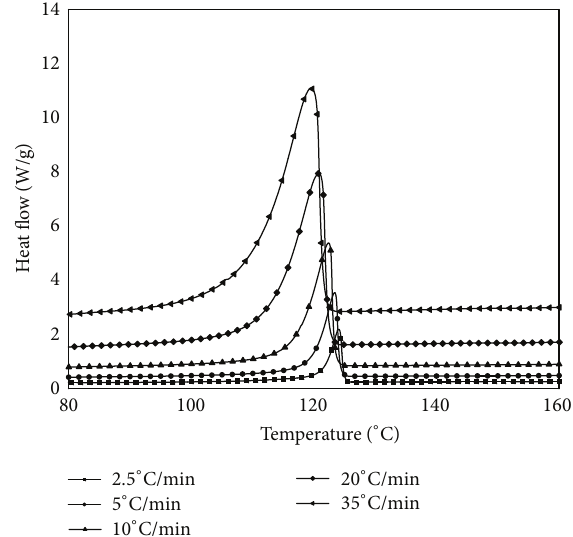
Figure 2: A comparison of heat flow curves of HDPE/heat-treated BF composites with heat-treated BFs at different cooling